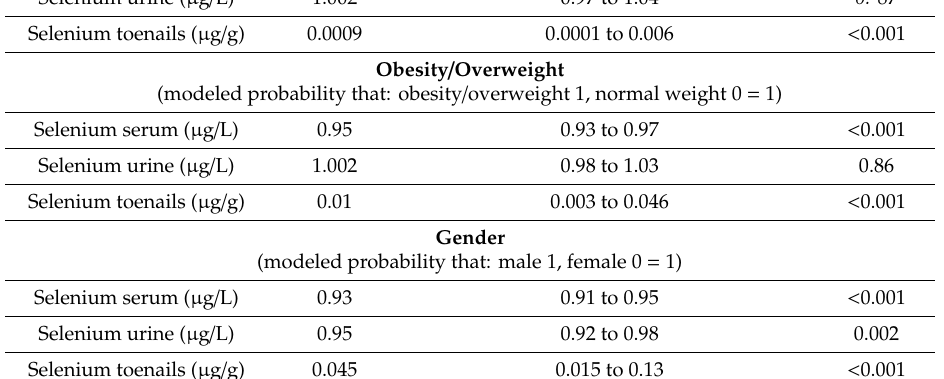
Table 4. Multivariate linear regression analyses of serum, urine and toenail selenium concentrations (model adjusted for age, TSH, fT3, fT4) and logistic regression models of the associations between the presence of ASD, the presence of obesity / overweight, or gender, and serum, urine and toenail selenium